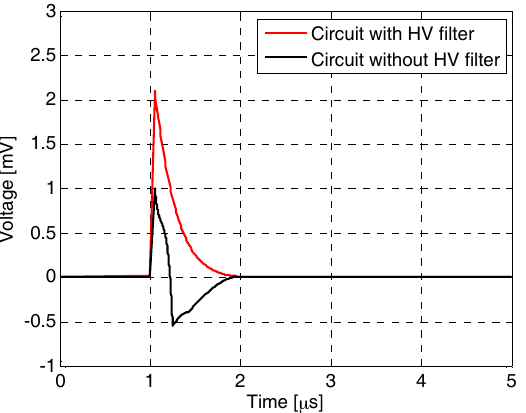
Figure 2. Calibrating signal measured in the testing circuit (Figure 1) supplied by a 30-m-long shielded cable.